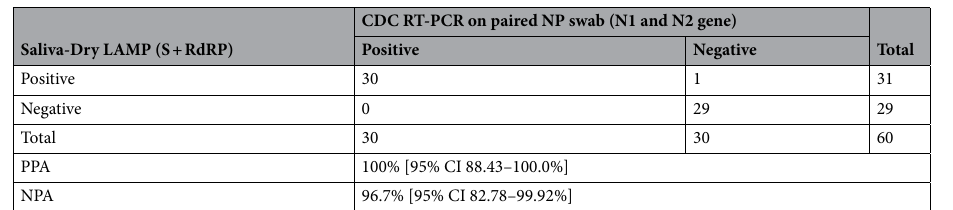
Table 2. Saliva-Dry LAMP clinical validation using paired saliva and NP swabs obtained compared to the reference standard CDC RT-PCR method. Saliva-Dry LAMP was performed using commercially-available instruments and lyophilized RT-LAMP reactions from Pro-Lab Diagnostics Inc. PPA positive percent agreement, NPA negative percent agreement, S spike, RdRP RNA-dependent RNA polymerase.